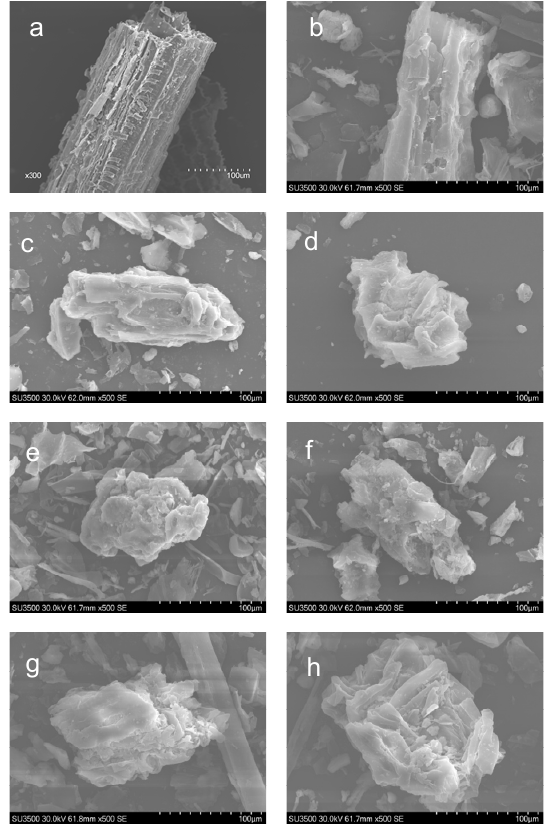
Figure 1. SEM images of the corn straws (CSs) with different ball grinding times (( a , b ): CS-0h; ( c ): CS-0.5h; ( d ): CS-1h; ( e ): CS-1.5h; ( f ): CS-2h; ( g ): CS-4h; and ( h ): CS-8h).